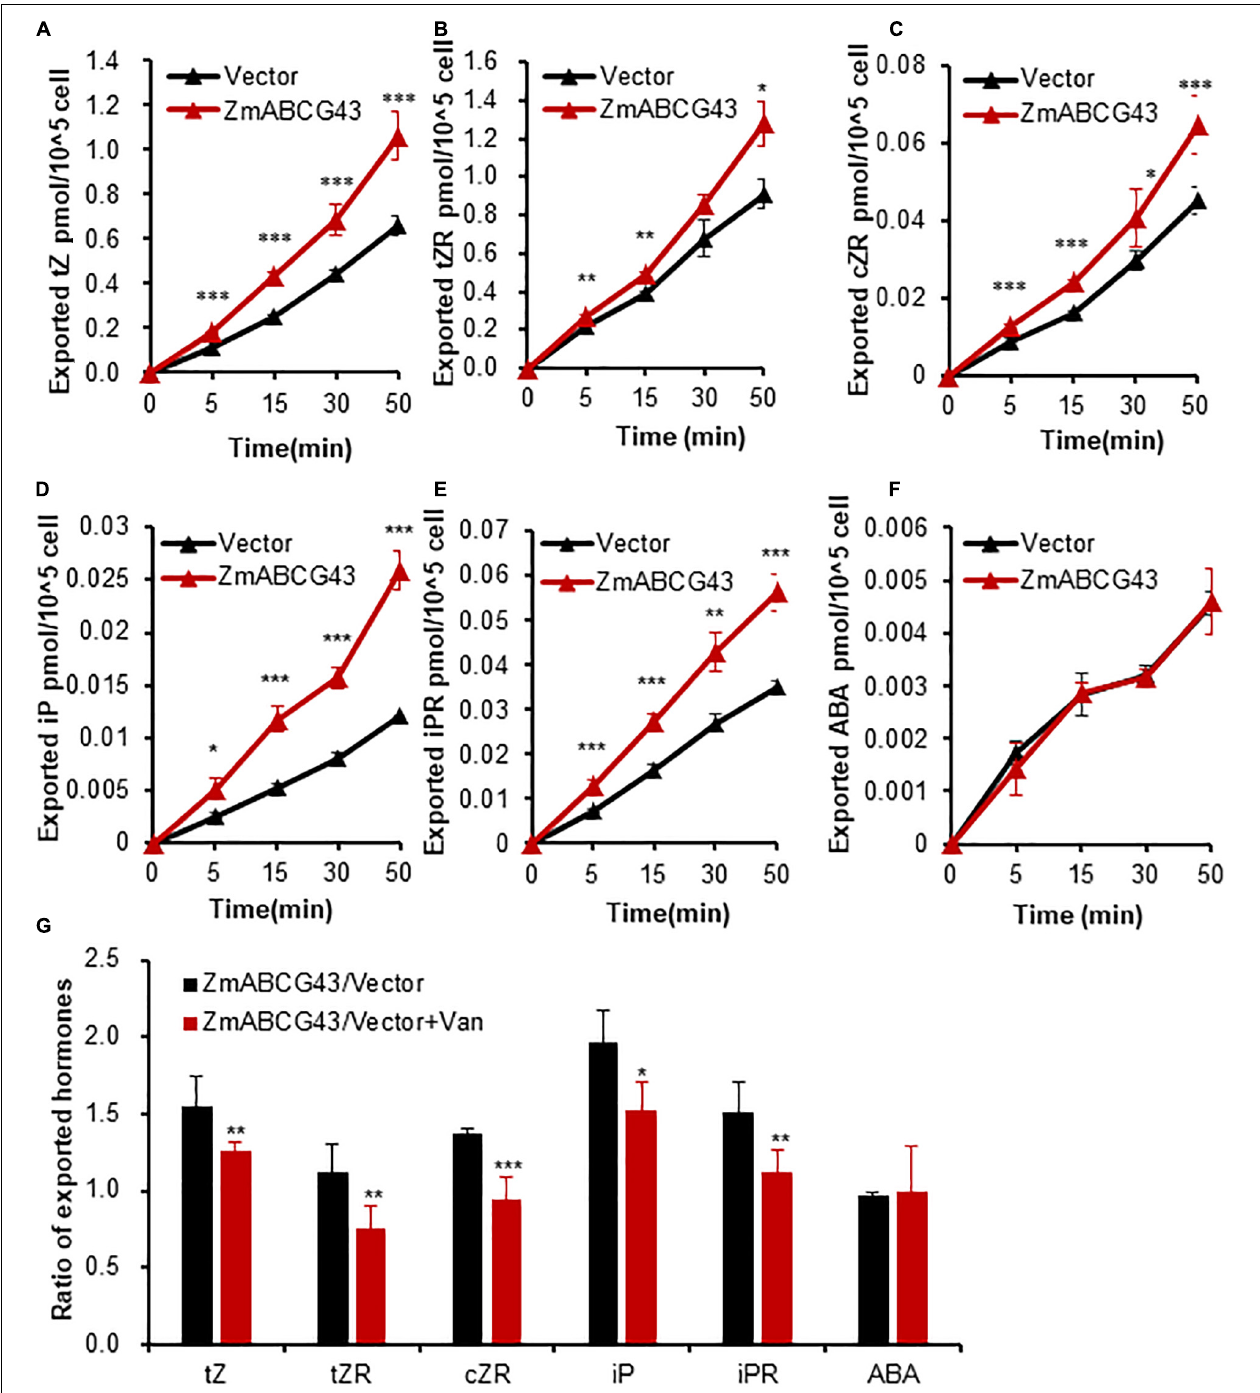
FIGURE 6 | ZmABCG43-mediated efflux transport of various cytokinins in protoplasts prepared from the agroinfiltrated tobacco leaves. (A–F) Quantification of exported tZ, tZR, cZR, iP, and iPR from protoplasts isolated from tobacco leaves transformed with GFP - ZmABCG43 or free GFP at the time points of 0, 5, 15, 30, and 50 min. (G) The ratios of efflux transported cytokinins from tobacco protoplasts transformed with GFP-ZmABCG43 and free GFP in the presence or absence of 1 mM of sodium vanadate at 30 min. Data are means ± SE ( n = 4). *, **, and *** indicate P -values of P < 0.05, P < 0.01, and P < 0.001, respectively, from Student’s t -test. ZG43,